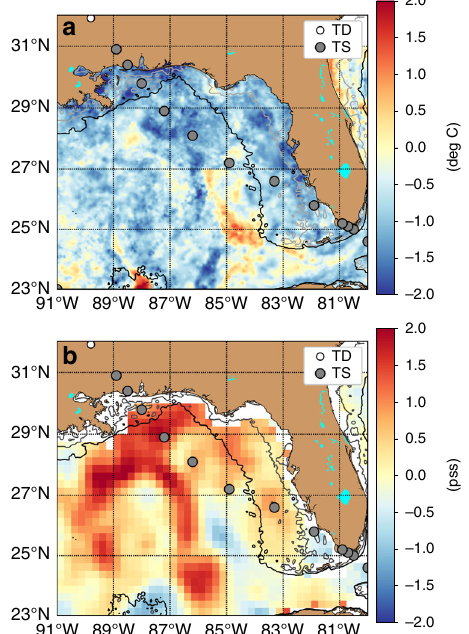
Fig. 6 Surface temperature and salinity differences. Surface ocean property differences in a temperature and b salinity before and after the passage of TS Gordon, with the circles showing the storm track of Gordon as tropical storm (TS) and depression (TD). Dictated by data availability, the temperature difference was determined using the conditions on August 28 and September 7, 2018, and the salinity difference using September 2 and September 9, 2018. The gray and black contours are 20- and 100-m isobaths.